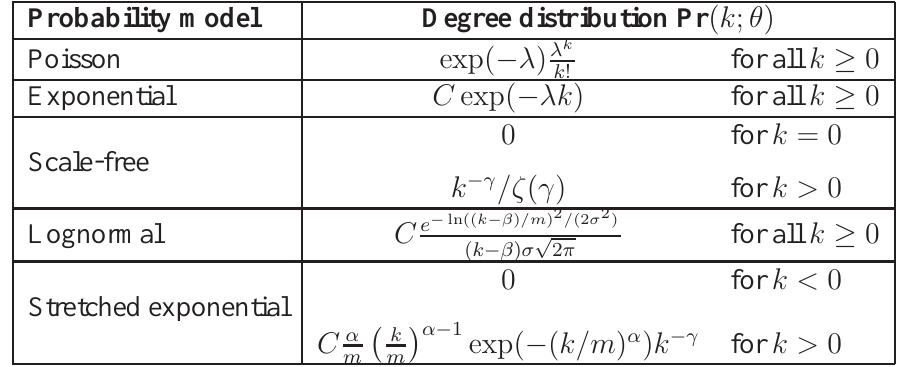
Table 1: The five network models and their degree distributions, Pr ( k ; θ ) used in the analysis, below. Wherever it appears, C denotes the normalizing constant such that [28, 29] we analyzed the effects of other, such as trunacted scale-free models, but these were still found to be inferior to the lognormal and stretched exponential